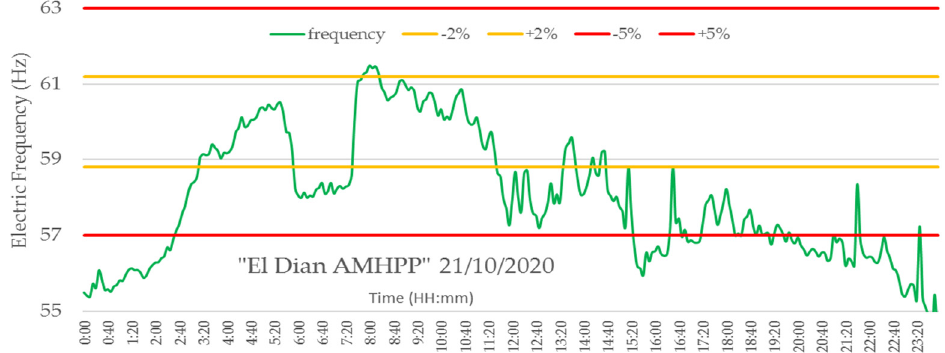
Figure 1. Typical behavior of the frequency of a mini-hydroelectric without